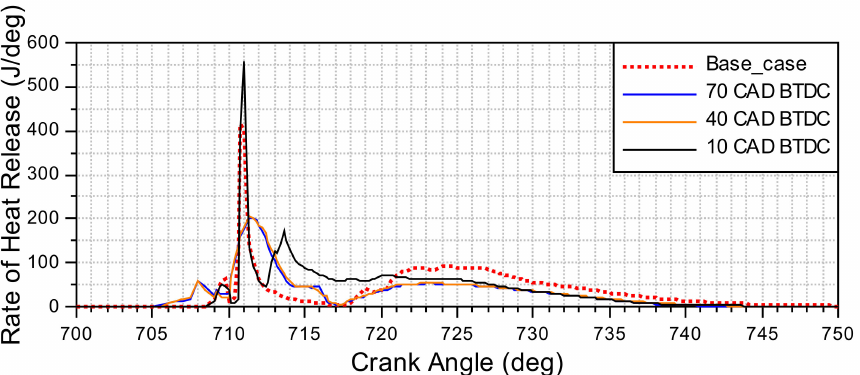
Figure 8. ROHR for the 1st pilot SOI